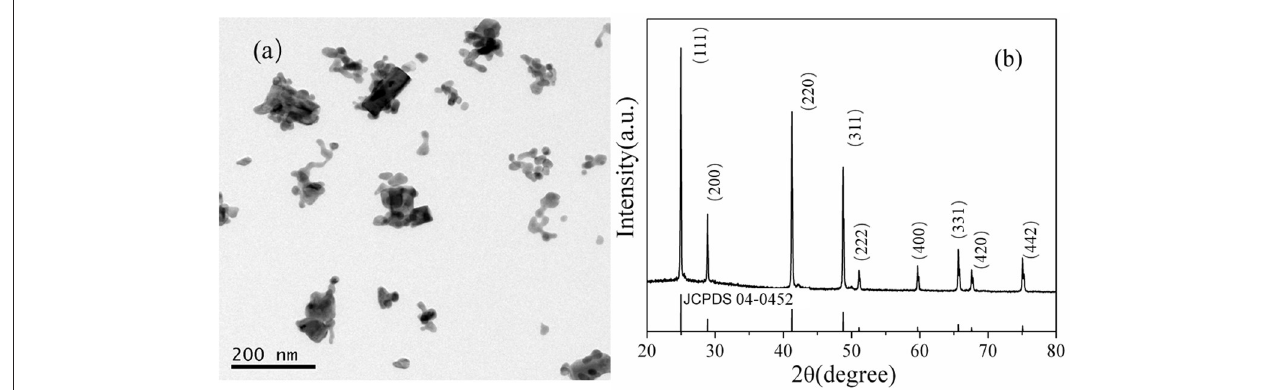
FIGURE 1 | TEM images (a) and XRD patterns (b) of BaF 2 :Nd (3 mol%)